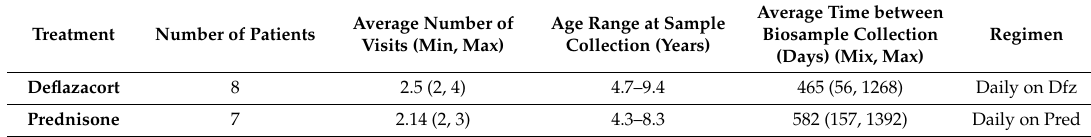
Table 1. Characteristics of patients / samples for SOMAscan ® screening dataset A. All samples were from ambulatory patients.